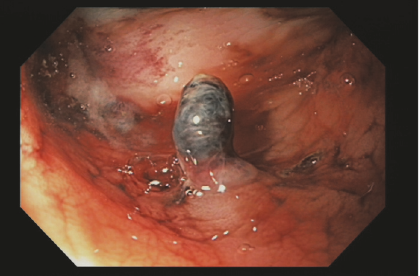
Figure 2: Endoscopic visualization of a single pulsatile artery protruding from the rectal mucosa consistent with a Dieulafoy’s